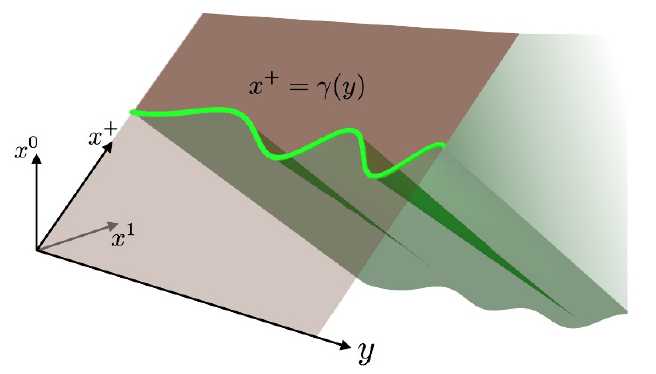
Figure 1 . Region with boundary x + = (cid:13) ( y ) (green curve) on the null plane x (cid:0) = 0 and parallel to k = (1 ; 1 ; 0 ; : : : ). Here y are the d (cid:0) 2 transverse